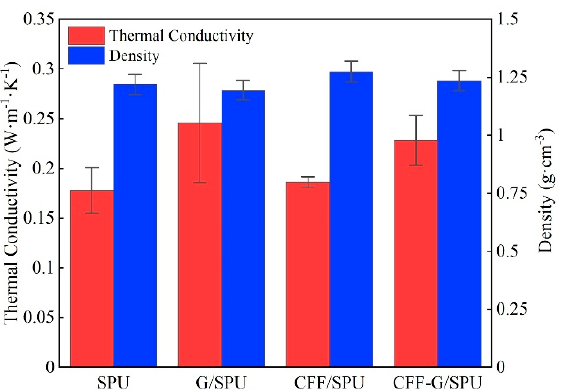
Figure 4. Thermal conductivities and densities of SPU, G/SPU, CFF/SPU and CFF-G/SPU.